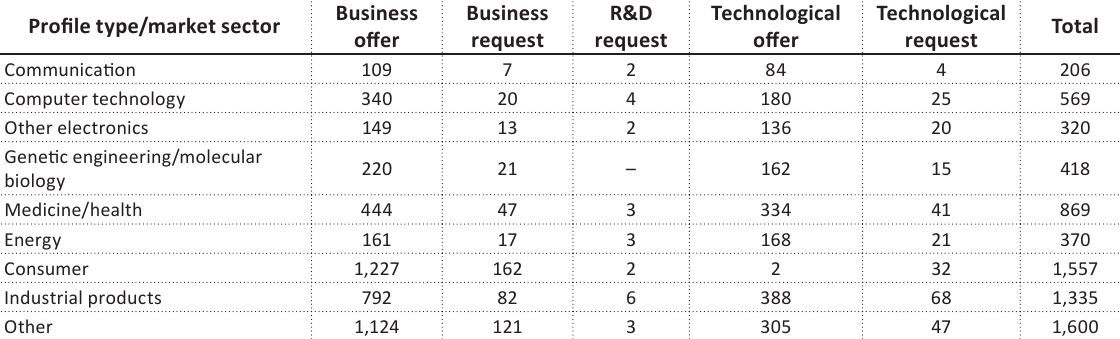
Table 2. Systematization by types of profiles of business entities in the EEN system which are interested in cooperation with entities from Ukraine for the first half of 2019 Source: Compiled by the authors based on the Enterprise Europe Network in Ukraine